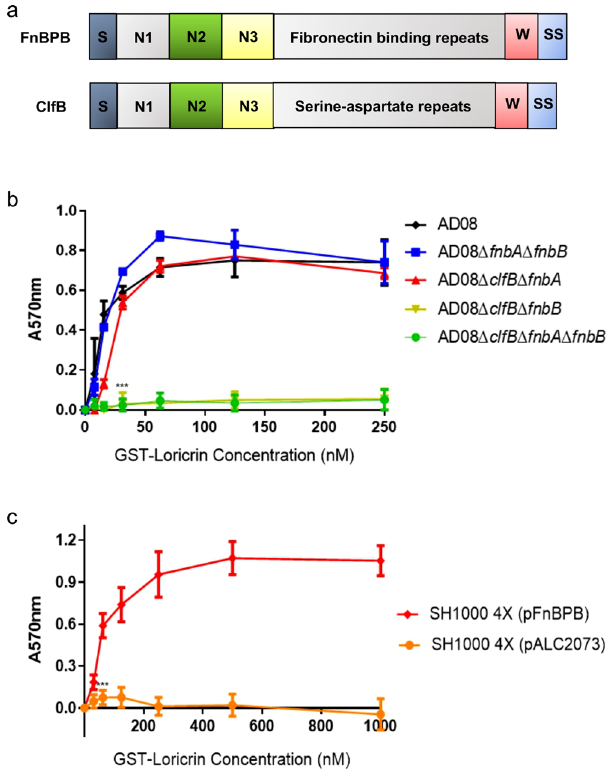
Fig. 1 FnBPB and ClfB mediate the adherence of S. aureus to loricrin. a Schematic diagram showing the domain organisation of FnBPB and